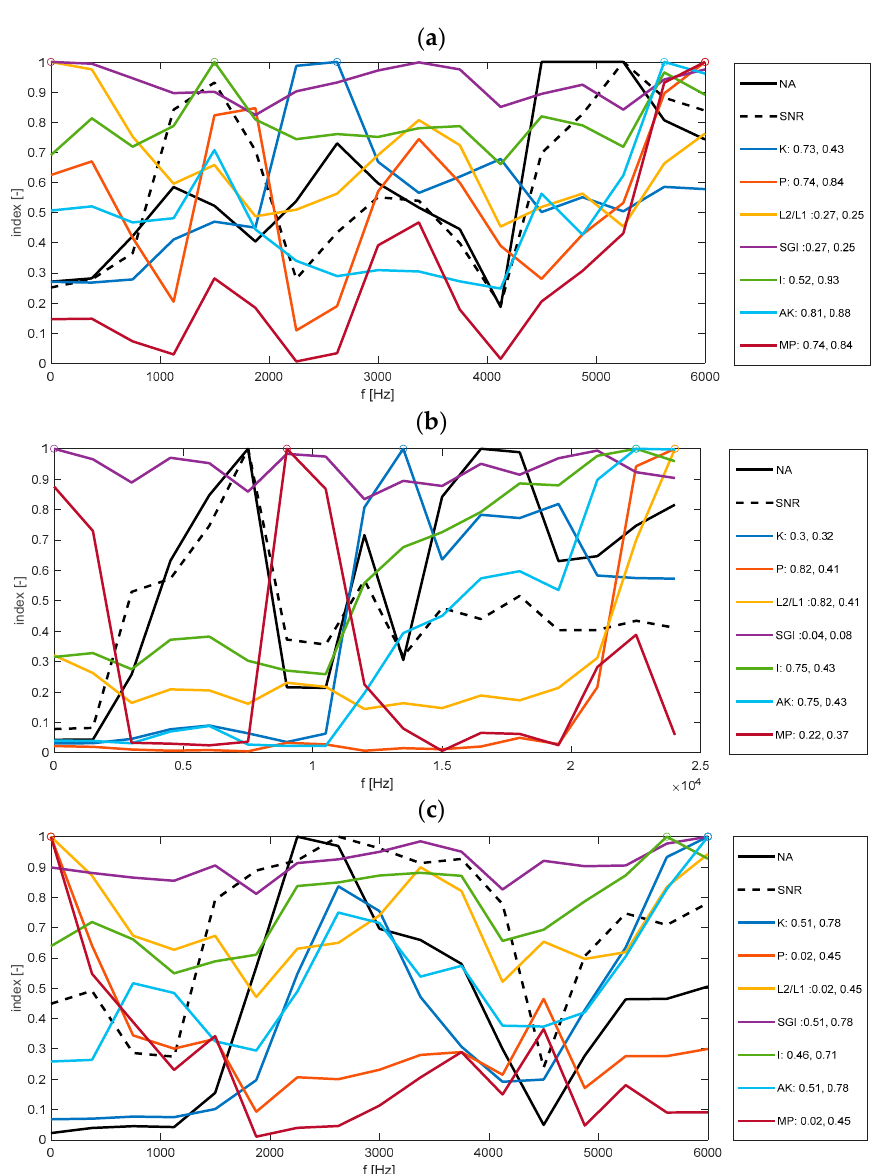
Figure 6. Traditional band indicators as a function of the center frequency f , compared to the proposed NA and SNR a posteriori indicators. The maximum of each indicator is highlighted by a circle, and the value of NA and SNR at that point are reported in the legend. The average of such two values produces the (cid:1861)(cid:1831) which is summarized in Table 3. ( a ) IR014_1, ( b ) IR014_3, ( c ) B021_0.